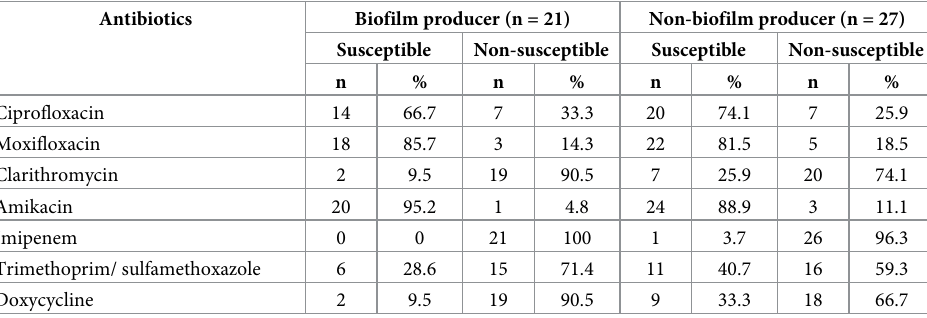
Table 4. Antibiotic susceptibility and biofilm formation in the M . fortuitum